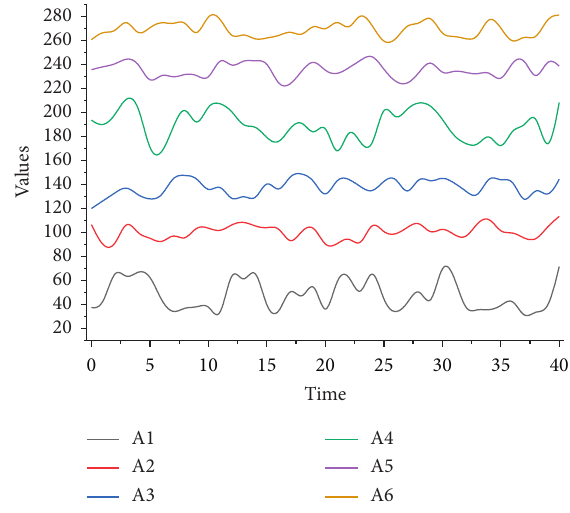
Figure 6: Schematic diagram of the statistical folding